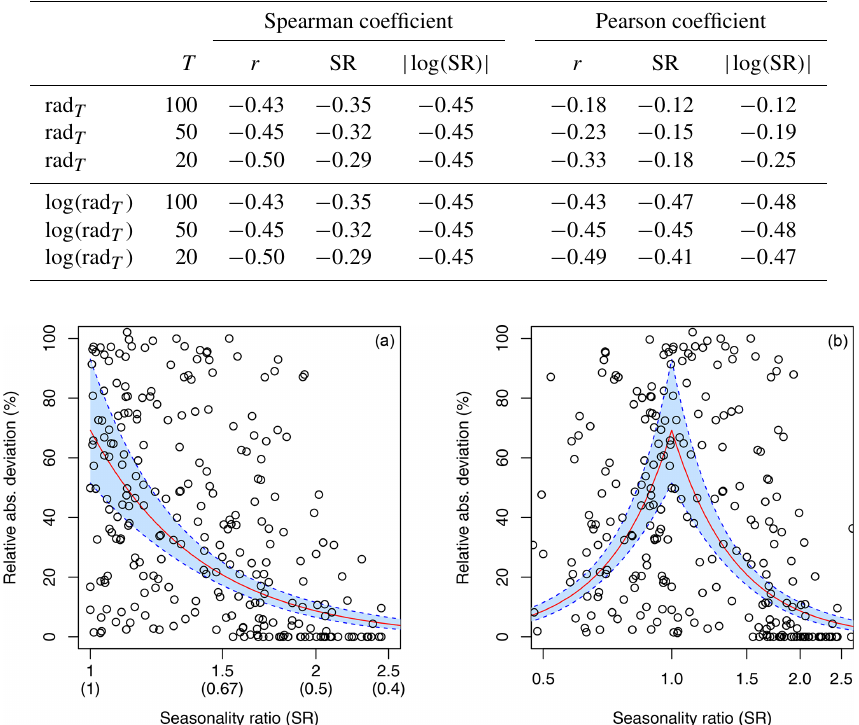
Figure 5. Performance gain by seasonality ratio (SR). Shown is the log-linear model between relative absolute deviation (rad T ) and absolute logs of SR (red lines refer to the expected values, blue to their 95% confidence bounds). Black points are the observations. In panel (a) SR < 1 are plotted as inverted values (1 / SR) and labelled by the numbers in parentheses. Panel (b) plots the same relationship for the original values of